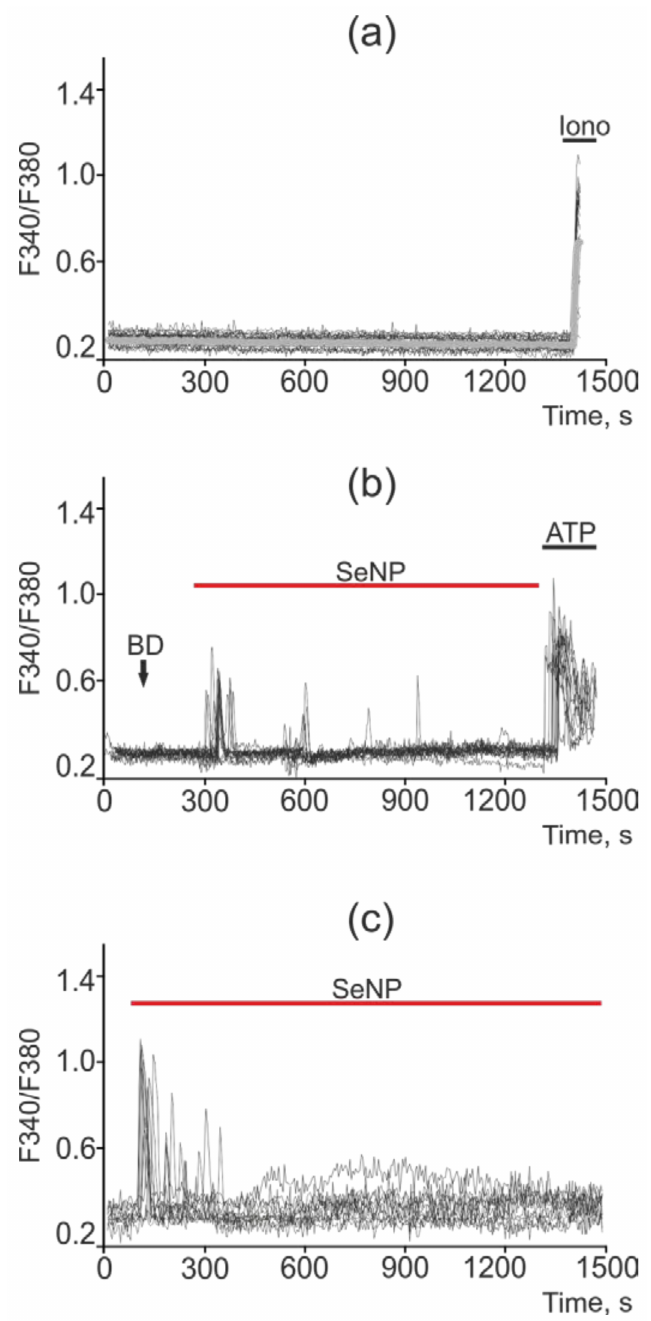
Figure 11. Ca 2+ signals in control DU-145 cells ( a ) and in response to application of 0.5 µ g/mL ( b ) and 2.5 µ g/mL ( c ) SeNP. BD = application of bi-distilled water equivalent to the amount of SeNP solvent. At the end of the experiment, the Ca 2+ ionophore, Ionomycin (Iono, 1 µ M), or the purinoreceptor activator, ATP (10 µ M), was applied to normalize the [Ca 2+ ]i signal to the maximum. Typical Ca 2+ signals of cells are